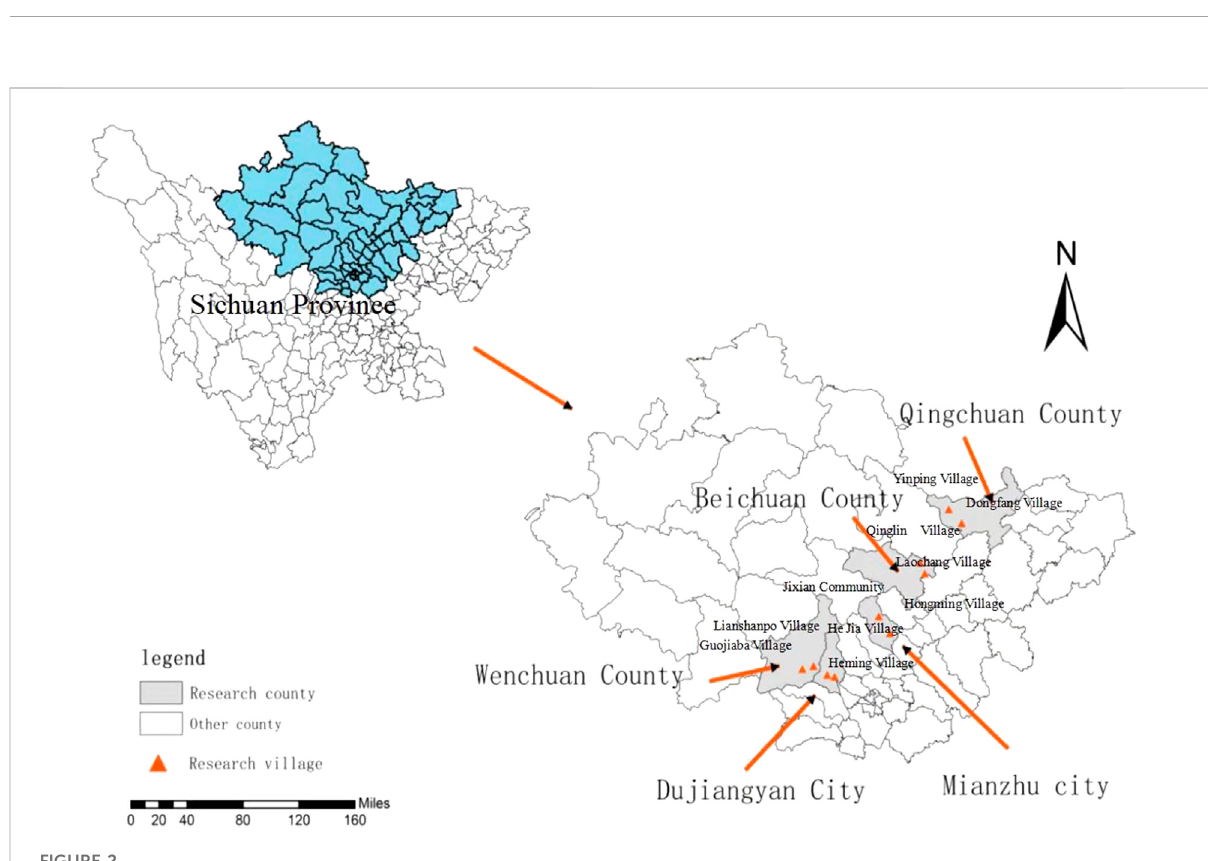
FIGURE 2 The location of the sample